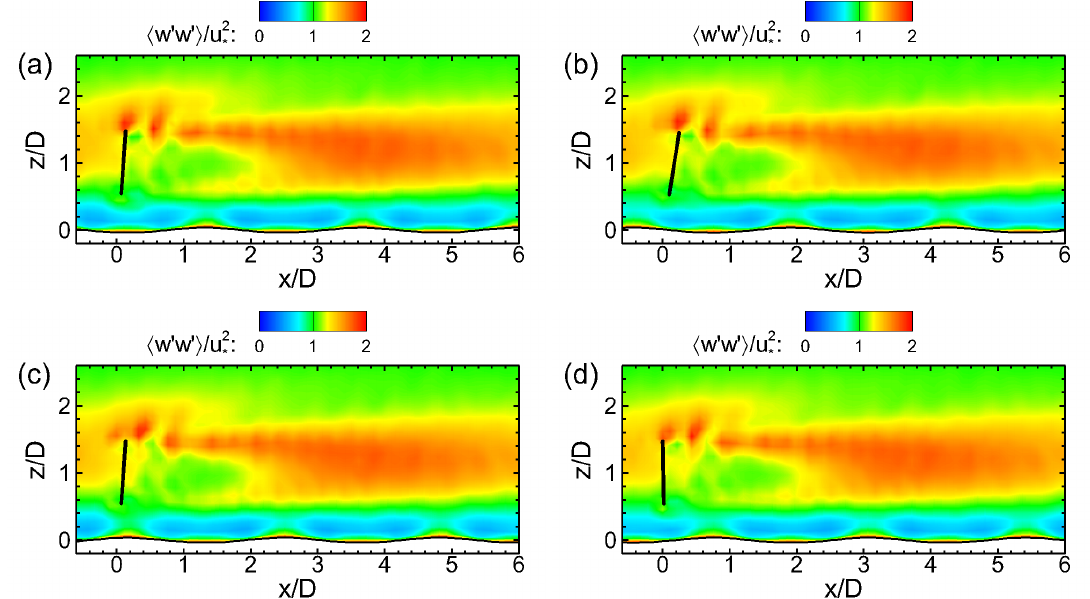
Figure 7. Swell-phase averaged vertical wind-velocity variance (cid:104) w (cid:48) w (cid:48) (cid:105) at four representative swell phases for pitching-turbine case: ( a ) trough (Phase 1); ( b ) forward slope (Phase 2); ( c ) crest (Phase 3); and ( d ) backward slope (Phase 4). Turbine-rotor-disk location indicated by thick black